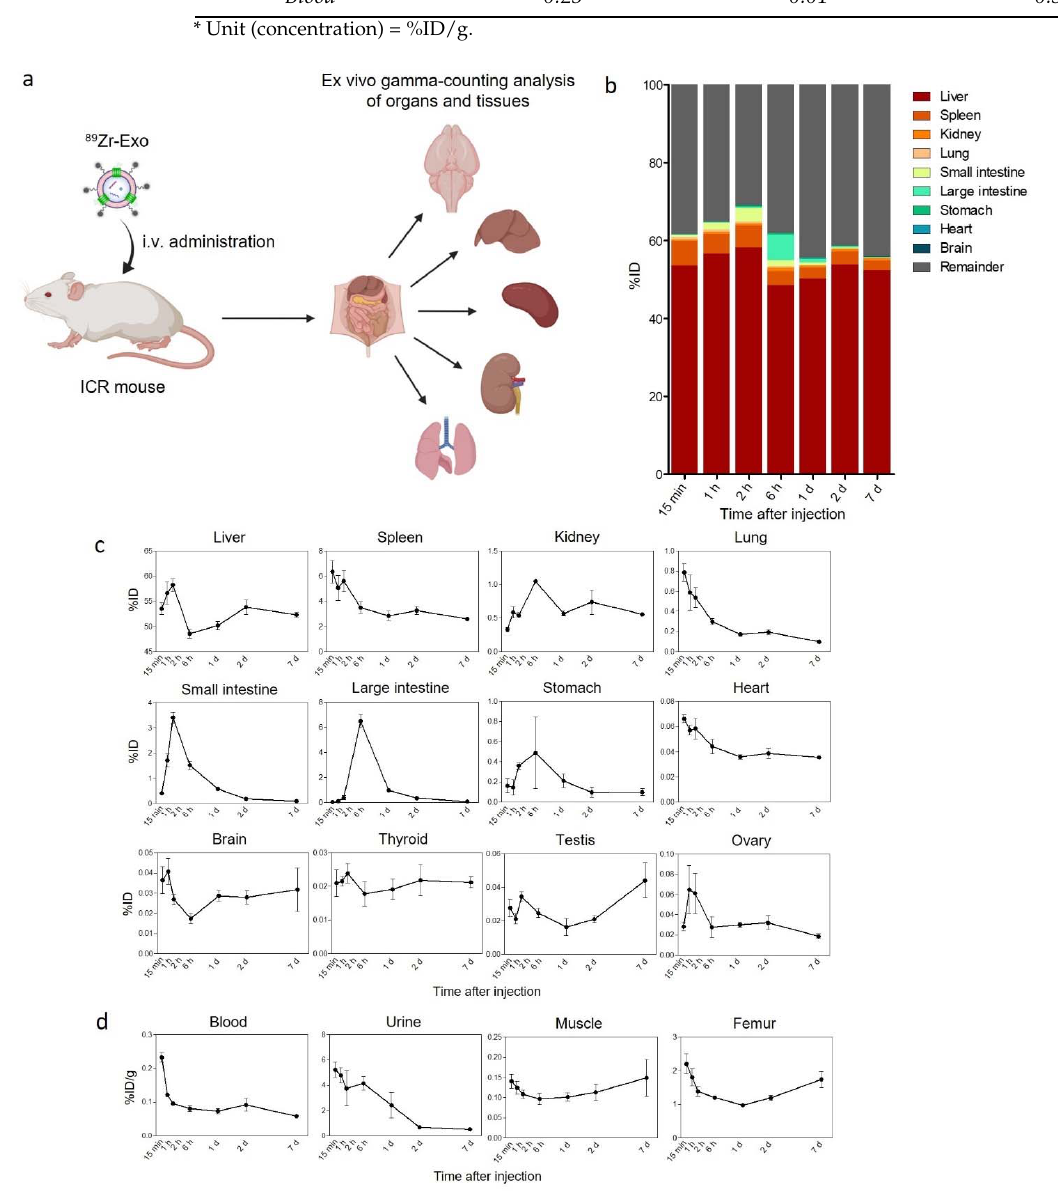
Figure 3. Biodistribution of 89 Zr-labeled GMP-grade exosomes in mice analyzed using ex vivo gamma-counting analysis. ( a ) Schematic of the ex vivo gamma-counting analysis of the distribution of i.v.-administered 89 Zr-Exo in various organs and tissues of mice. ( b ) Whole-body fraction of 89 Zr- Exo in various organs of mice ( n = 4 for each time point) was determined using a gamma-counting assay, with the results shown as the %ID at various time points. ( c ) Time-course distribution of 89 Zr- Exo in each organ determined using a gamma-counting assay was shown as the %ID with SEM. ( d ) Time-course distribution of 89 Zr-Exo in the blood, urine, muscle, and femur was shown as the %ID/g with SEM due to differences in the sampling methods.